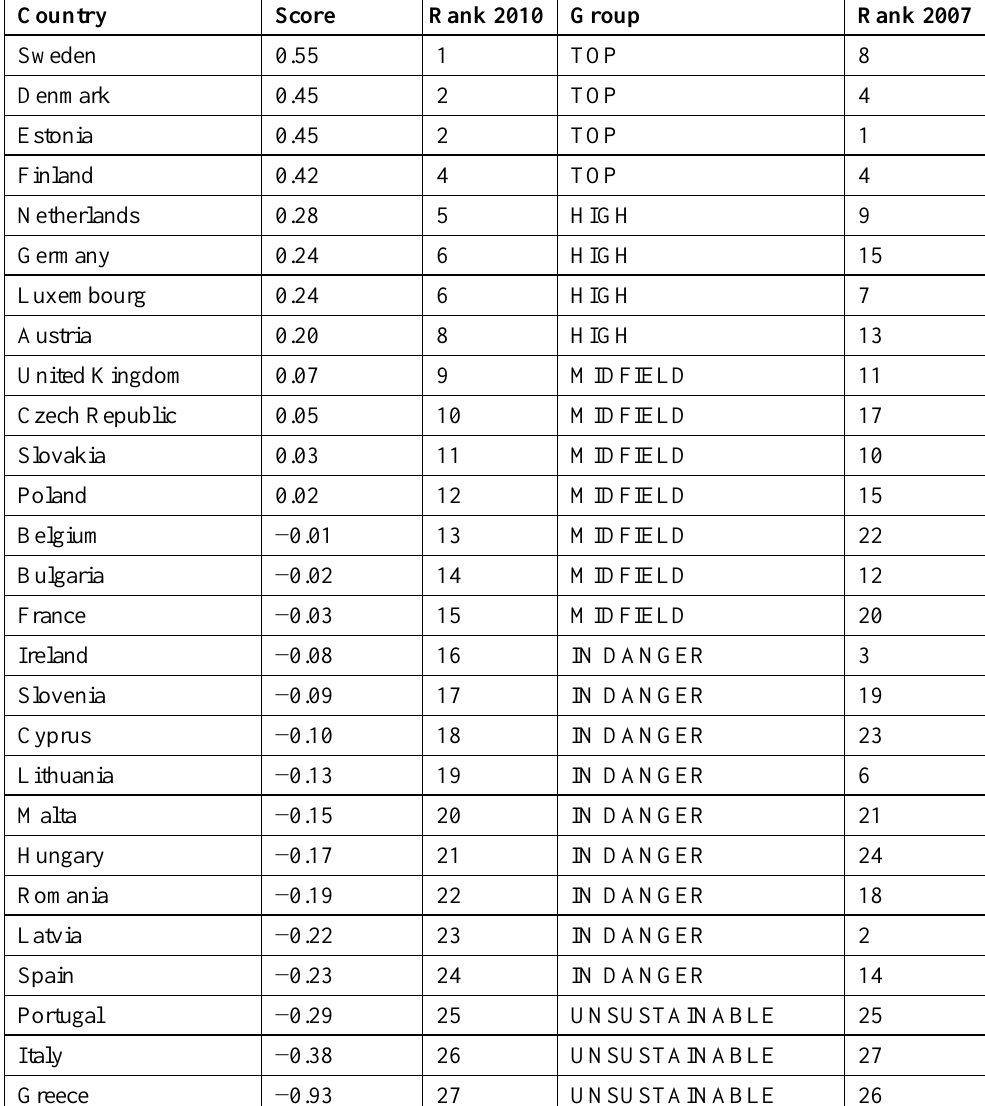
Table 2. European Economic Sustainability Index (EESI) in 2007 and 2010 (Zuleeg, 2010, p. 6) Country